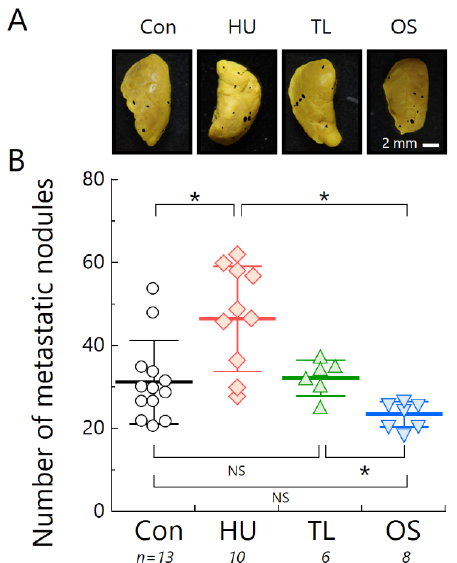
Figure 3. Number of lung metastatic nodules found under the four suspension conditions at 21 days after inoculation with murine osteosarcoma cell line (LM8) cells. ( A ) Representative photographs. Lung metastases are delineated and shaded in black. ( B ) Number of metastatic nodules. Circles, standard housing control group (Con); diamonds, hind-limb unloading (HU); triangles, temporary loading during HU (2 h per day) (TL); inverted triangles, orthostatic suspension (OS). Error bars indicate standard errors. * p < 0.05; NS, not significant (using Kruskal-Wallis test).